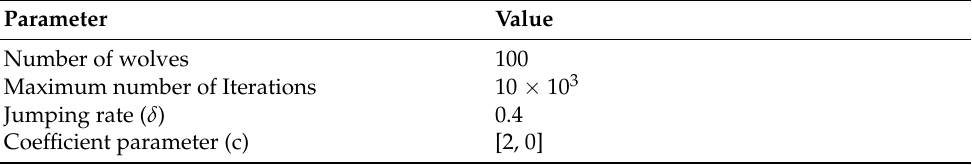
Table 4. Parameters of proposed